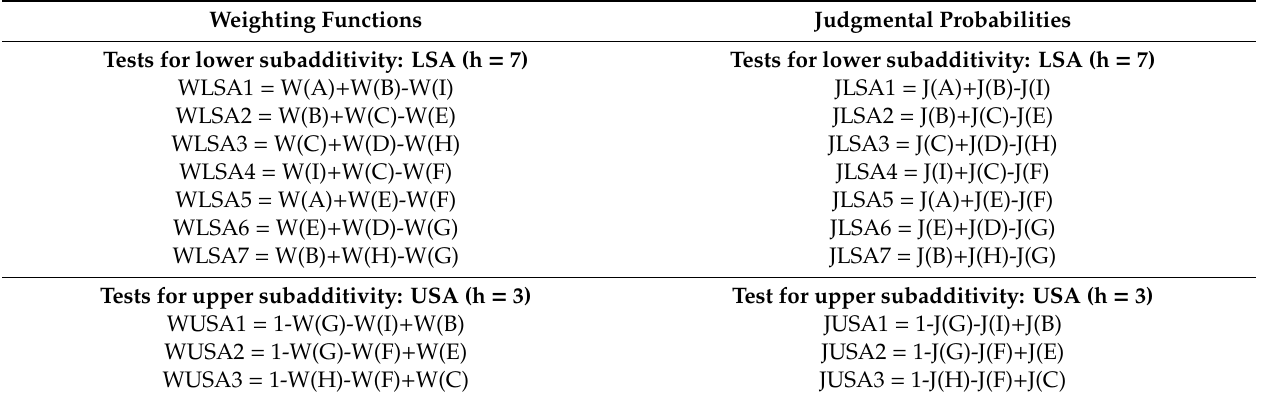
Table A4. Tests for bounded subadditivity (BA).